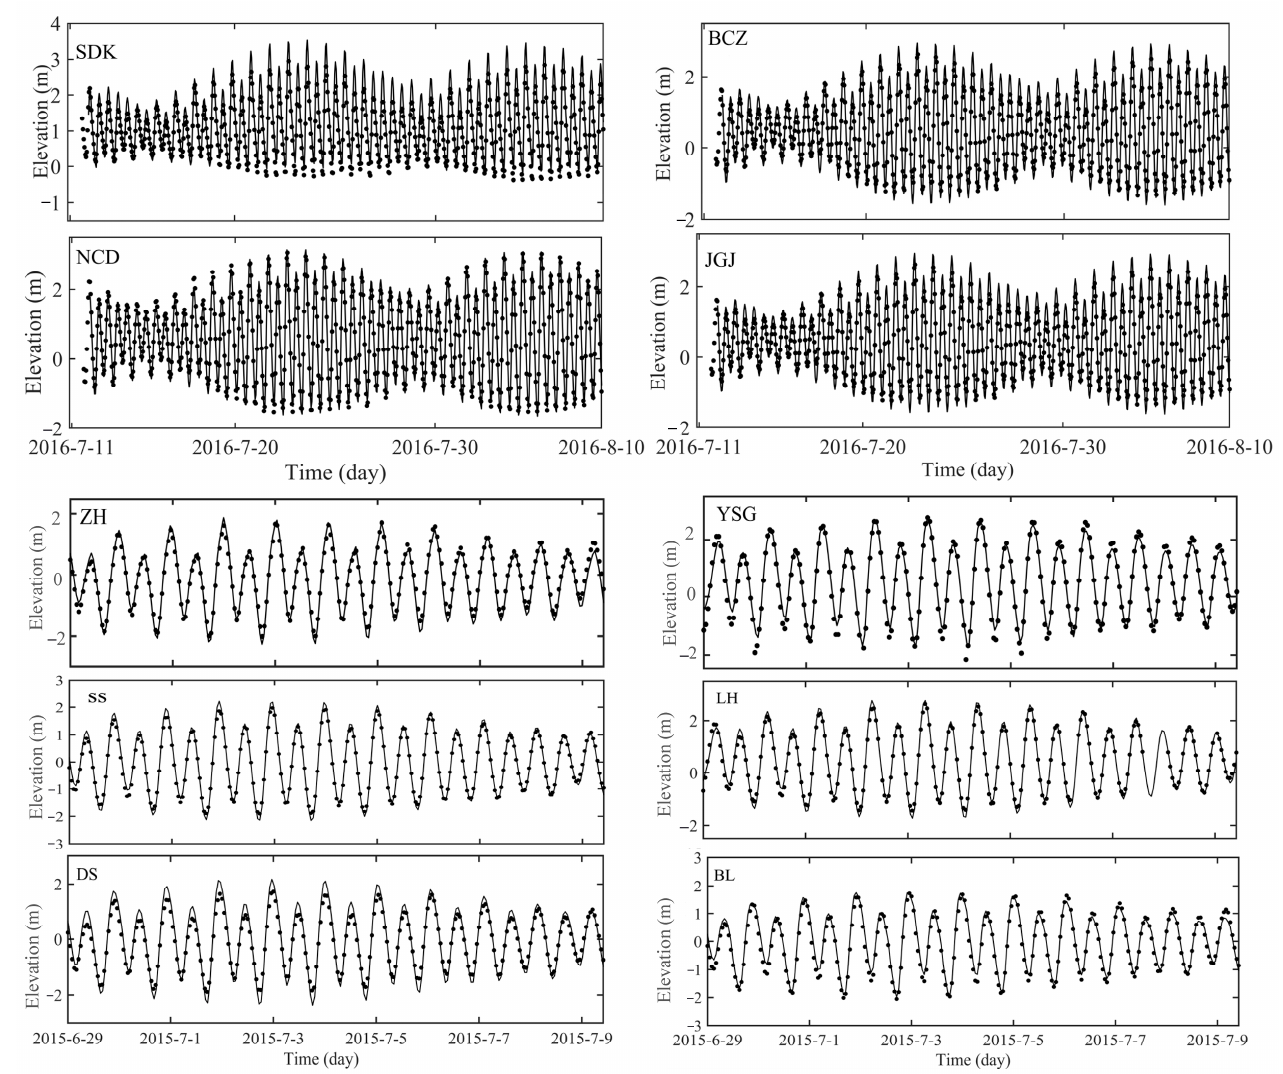
Figure 6. Verification of water level (dots denote the observed data; line denotes the simulation data). Using n = 0.01 + 0.01/ h and the numerical setting as shown in Section 3.1 (using the meshes considering the DNC), the tidal characteristics over the whole East China Sea, Yellow Sea and the Bohai Sea are simulated. T_tide program is applied to tidal harmonic analysis. Specifically, the time interval is set to be 1 h and the starting time is 9:00 on 1 February 2016. Harmonic analysis is carried out for each grid node. Figure 8 presents the spatial distribution of co-amplitude and co-phase of tide constituents, including M2 (Figure 8a), S2 (Figure 8b), K1 (Figure 8c) and O1 (Figure 8d) over the East China Sea, Yellow Sea and the Bohai Sea. It can be seen that interactions between incident waves and reflected waves of the semi-diurnal tides M2 and S2 lead to four amphidromic points: two in the Bohai Sea and the other two in the Yellow Sea. The distribution of diurnal tides K1 and O1 is very similar in the Yellow Sea and Bohai Sea. They have one amphidromic point in the Bohai Strait and the middle of the Yellow Sea, respectively. The co-phase lines radiate from the amphidromic point to the surrounding areas, and the co-amplitude lines present concentric ring distribution centered on the amphidromic point. The above simulation results are consistent with observations for the major tide constituents of M2, S2, K1 and O1 [44]. Furthermore, the largest M2 tidal range shown in Figure 8a appears along the west coast of the Korean peninsula, especially in the area near Kyunggi Bay, where its maximum tidal amplitude exceeds 2.0 m. Along the coast of China, the tidal amplitude